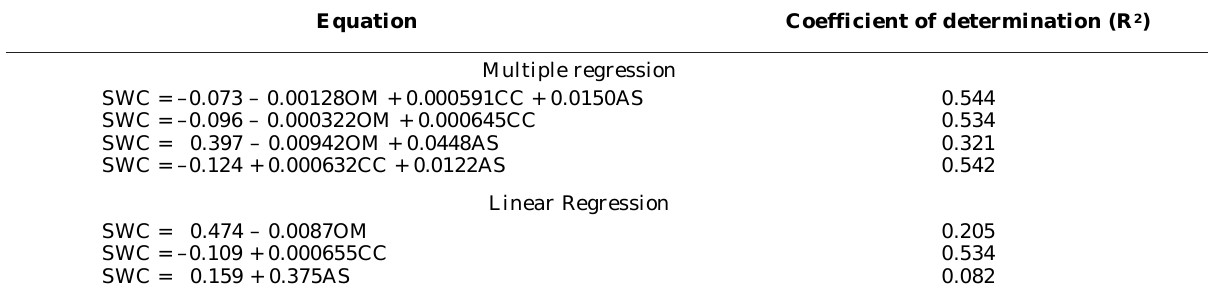
Table 1. Classical linear and multiple regression analyses of the four sets of